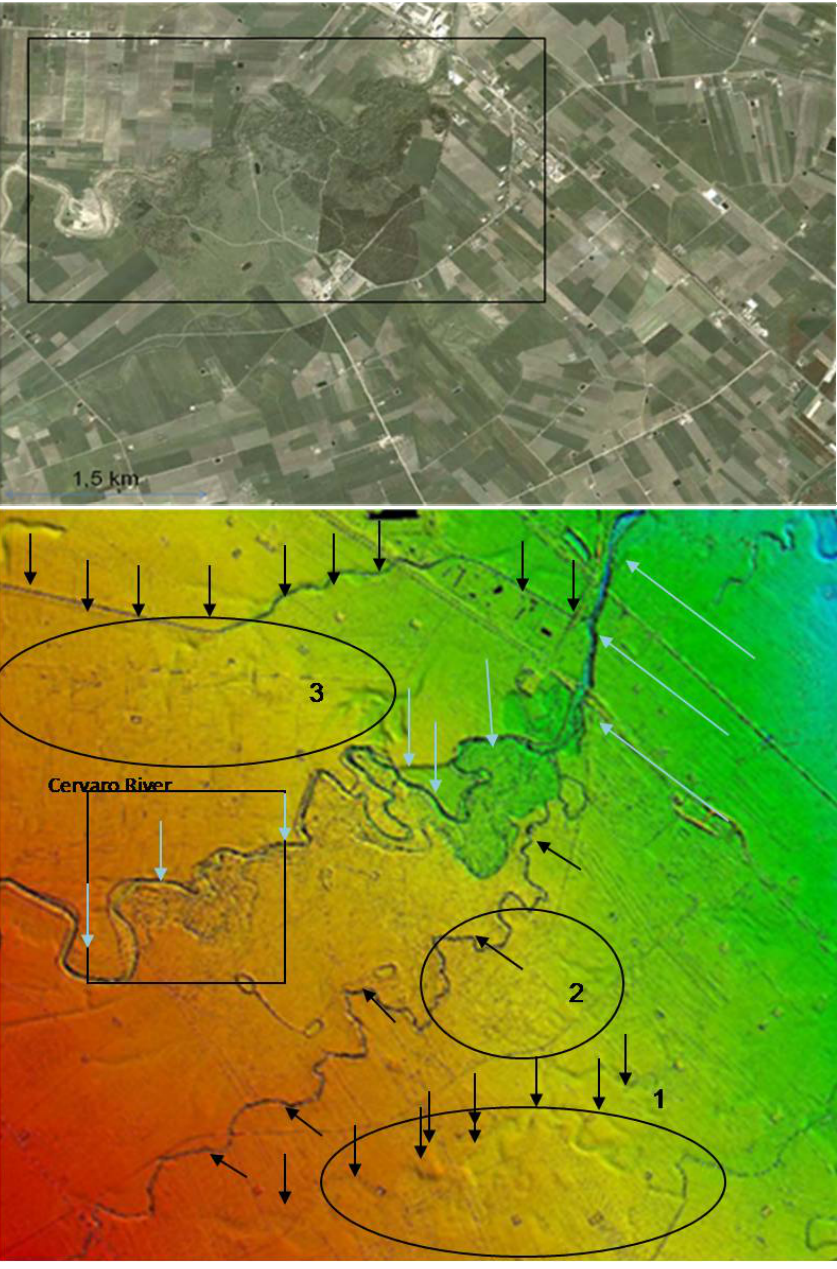
Figure 4: (up) ortophoto of the study area; (bottom) DTM from LiDAR, rectangle indicates the area of the mayor interest from the landscape archaeology prospective. Black arrows indicate the paleaoriver bed of the Cervaro River, brown arrows indicate the actual stream of the river. Circles indicate trace of past human activities.